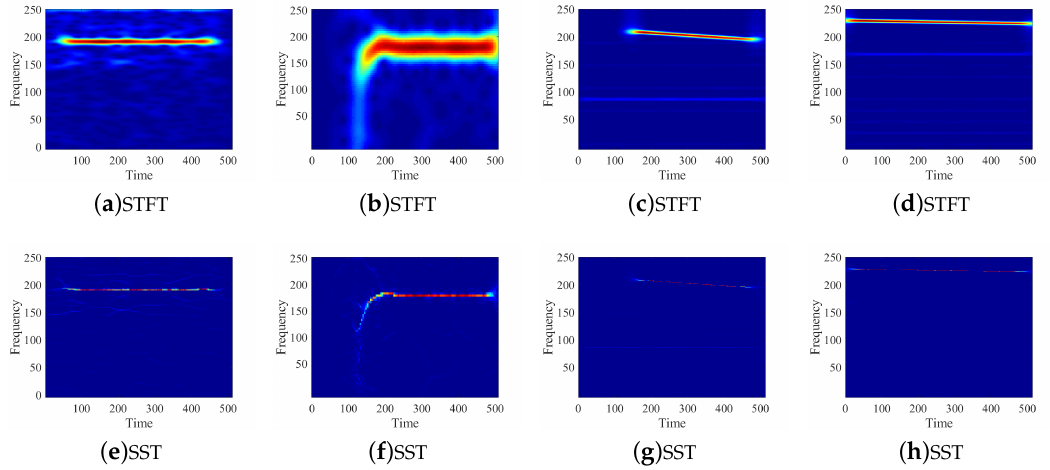
Figure 11. STFT and SST spectrum of Dataset, the signal in ( a ) and ( e ) is from DatasetI, the signal in ( b ) and ( f ) is from DatasetII, the signal in ( c ) and ( g ) is from DatasetIII, the signal in ( d ) and ( h ) is from